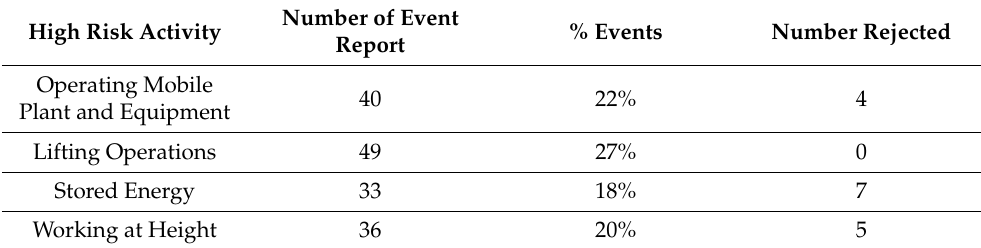
Table 3. Data analyzed by MAE